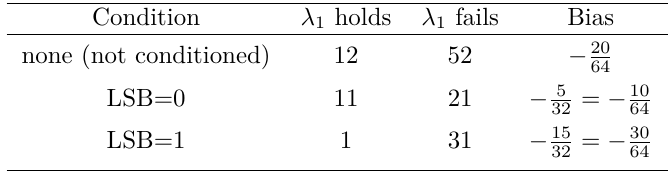
Table 3: Condition on the LSB of the Four Output Bits of S